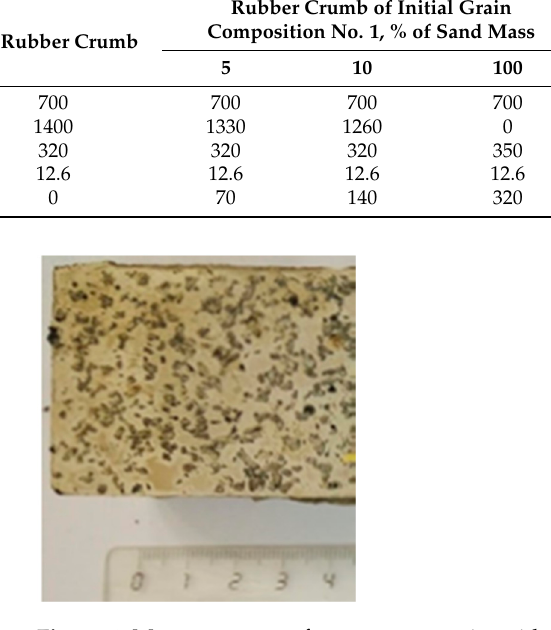
Figure 4. Macrostructure of cement composite with rubber crumb.